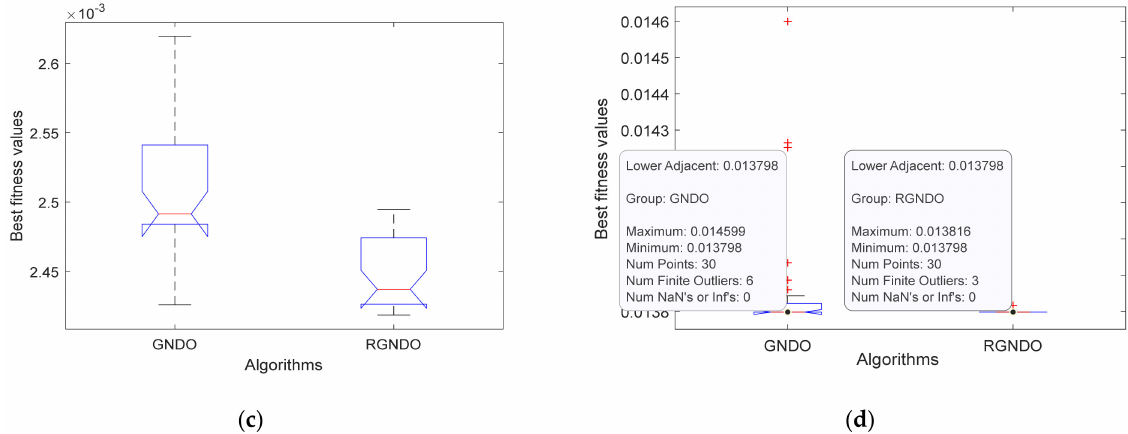
Figure 7. Boxplot achieved by GNDO and RGNDO: ( a ) Boxplot on RTC France; ( b ) Boxplot on Kyocera KC200GT; ( c ) Boxplot on Ultra 85 − P; ( d ) Boxplot on STP6 − 120/36.